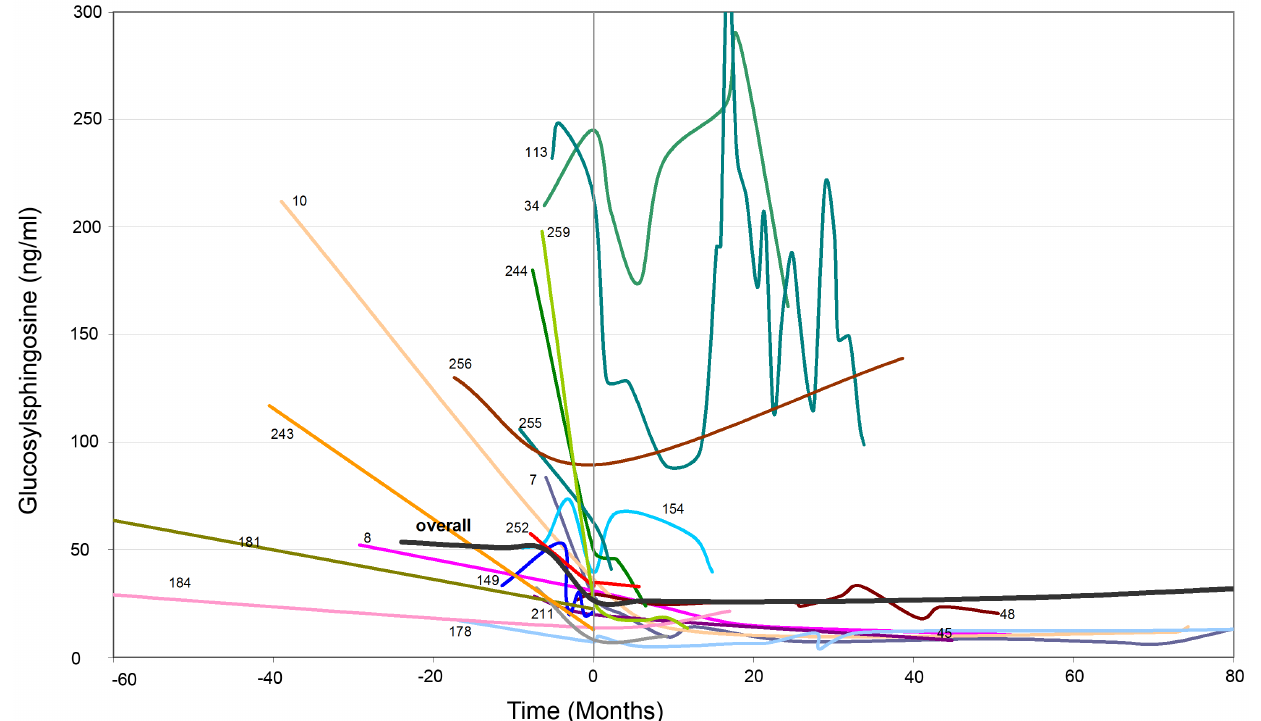
Figure 5. Monitoring of enzyme replacement therapy by Glucosylsphingosine. Course of Glucosylsphingosine after onset of treatment, the time point zero representing the first value after onset of therapy. The course for 19 GD patients undergoing ERT is shown. In summary the following genotypes were detected: # 256: N370S/N370S; # 7, # 8, # 181, # 242: N370S/L444P; # 10, # 113, # 149, # 154, # 178, # 184, # 211 are N370S/other. Two severely affected patients, 113 and 34, had been started with ERT for 10 months (pts. 113) and 4 months (pts. 34), respectively, but stopped due to shortage of the treatment. With the beginning of the ERT Glucosylsphingosine dropped down immediately, however went back to the original level after stopping of the ERT. After a second start with ERT 19 and 20 months, respectively, after initial starting the ERT the